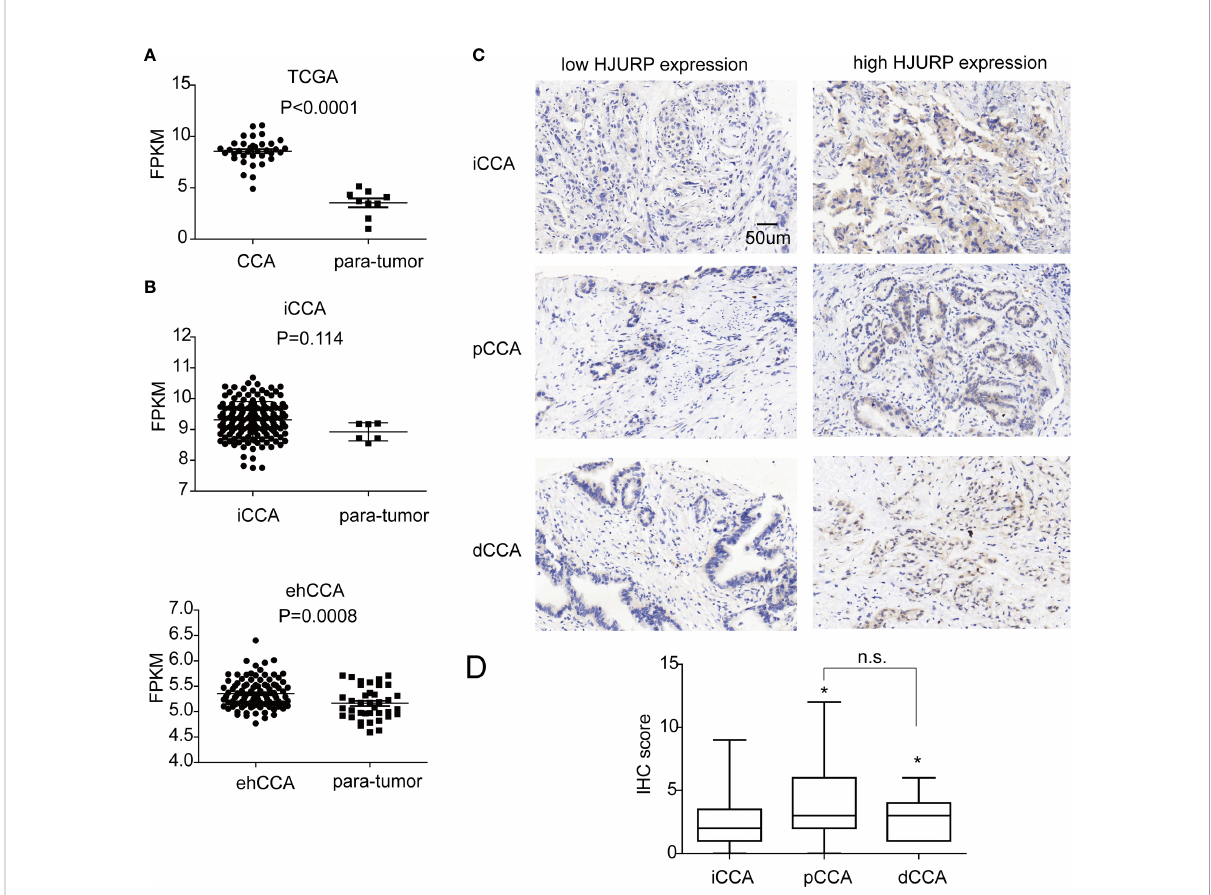
FIGURE 1 The expression of HJURP in CCA. (A) The fragments per kilobase of exon model per million mapped fragments (FPKMs) of HJURP in CCAs and para-tumor tissues in TCGA database. (B) The FPKMs of HJURP in iCCAs, ehCCAs, and their para-tumor tissues in the database with GSE33327 and GSE132305. (C) HJURP expression in CCAs was detected with IHC, dividing the patients into low and high HJURP expressions. (D) The IHC scores of pCCAs and dCCAs were higher than iCCAs. * represents P < 0.05, and n.s. represents not signi fi cant. In A, B, and D, statistical signi fi cance was analyzed by t